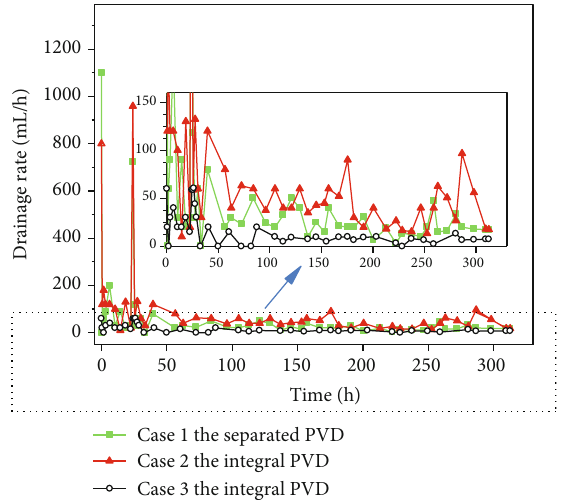
Figure 8: Variation curve of the drainage rate with time.